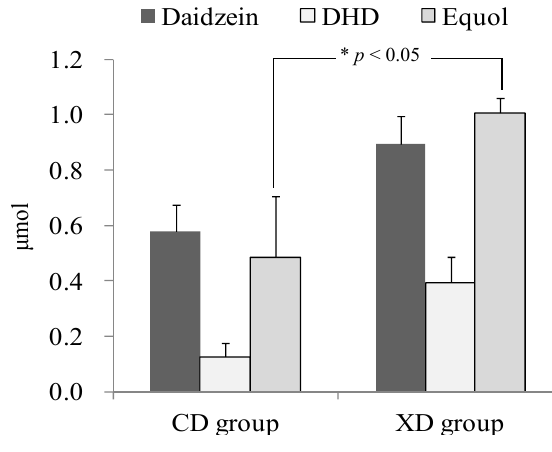
Figure 2. Amounts of urinary isoflavonoids of mice in the control diet (CD) group and the xylitol diet (XD) group. Enzymatic hydrolysis of the urinary isoflavone glucuronides was carried out with β -glucuronidase/arylsulfatase from Helix pomatia . We measured the urinary isoflavonoids as aglycones. Values are means ± SE ( n = 7). * Significantly different ( p < 0.05) from the CD group. The data were analyzed using the Student’s t -test (equol). Statistical significance was reached with a p value of less than